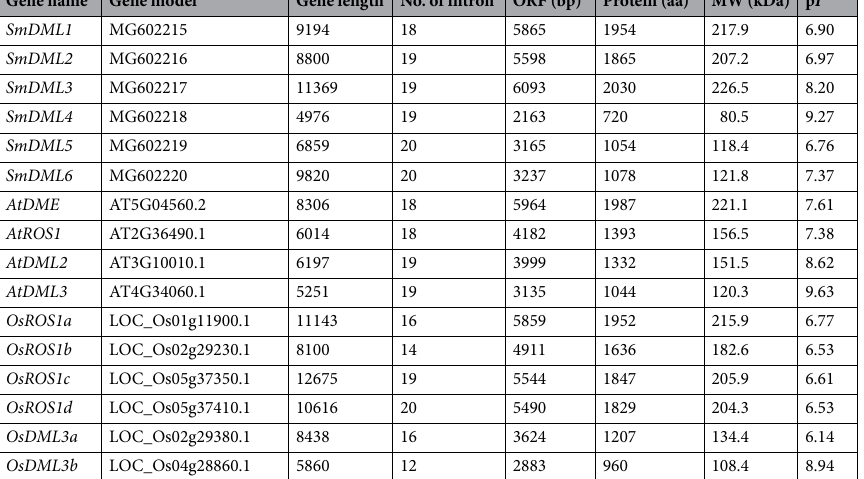
Table 1. Sequence features and intron numbers of SmDMLs , AtDMLs and OsDMLs .